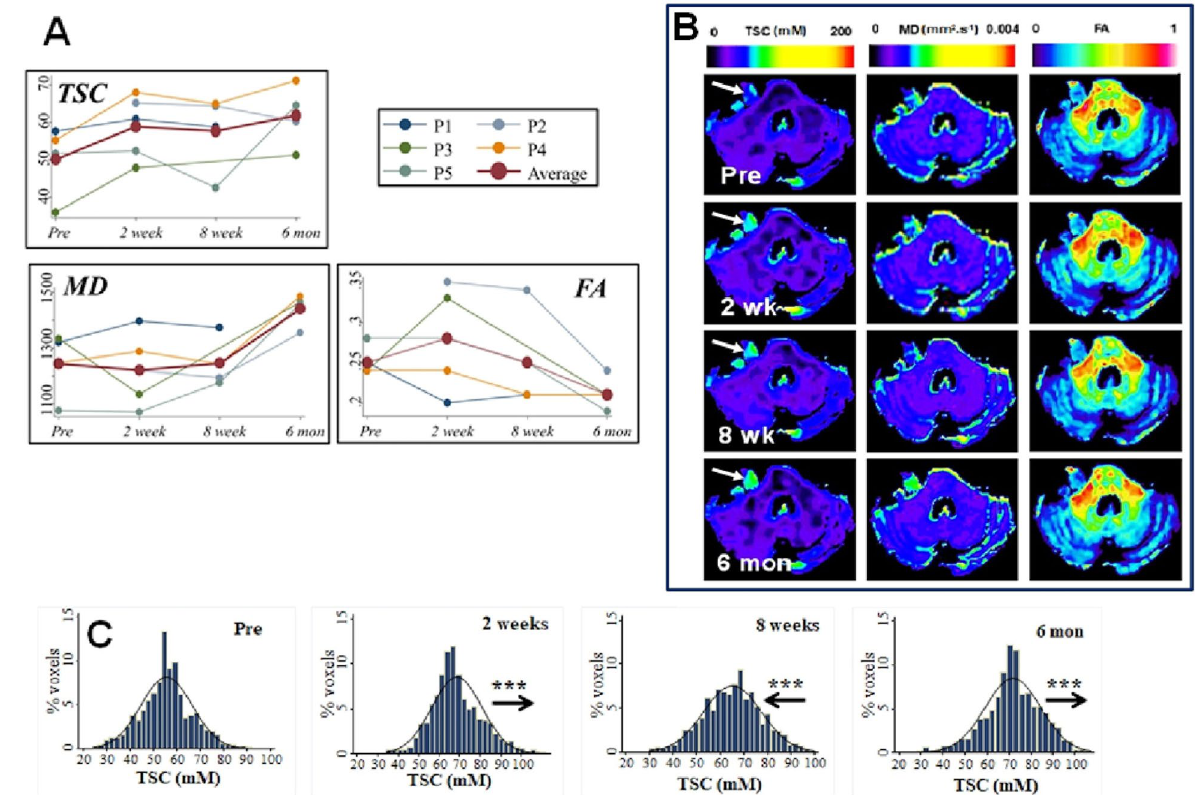
Figure 1. Post-SRS changes in tumour total sodium concentration (TSC) and diffusion metrics (MD, FA). ( A ) Line-graphs demonstrating temporal trend in mean tumour TSC (mM), MD (mm 2 s −1 × 10 −6 ) and FA (no units) for five VS. Average trend (red line) across all tumours also shown. ( B ) Representative TSC and diffusion metric maps from the right-sided growing VS shown in Panel A (patient 4, P4). From left to right: co-registered voxelwise maps of TSC, MD, and FA. Note the observable increase in TSC at 2 weeks, 8 weeks and 6 months post-SRS compared to pre-treatment values within the tumour ( arrow ) and the comparatively later visible increase in MD and reduction in tumoural FA observable at 6 months post-SRS. ( C ) Histogram of voxelwise TSC values within the tumour shown in panel B (patient 4, P4). From left to right: Pre-treatment, 2 weeks post-treatment, 8 weeks post-treatment, and 6 months post-treatment. Note the rightward shift in voxelwise TSC values at 2 weeks, 8 weeks, and 6 months post-treatment compared to pre-treatment values. *** p < 0.001 for comparison with pre-treatment TSC value, repeated-measures ANOVA with post hoc (Bonferroni) analysis of pairwise comparisons. Arrows show movement in histogram relative to preceding imaging timepoint. FA